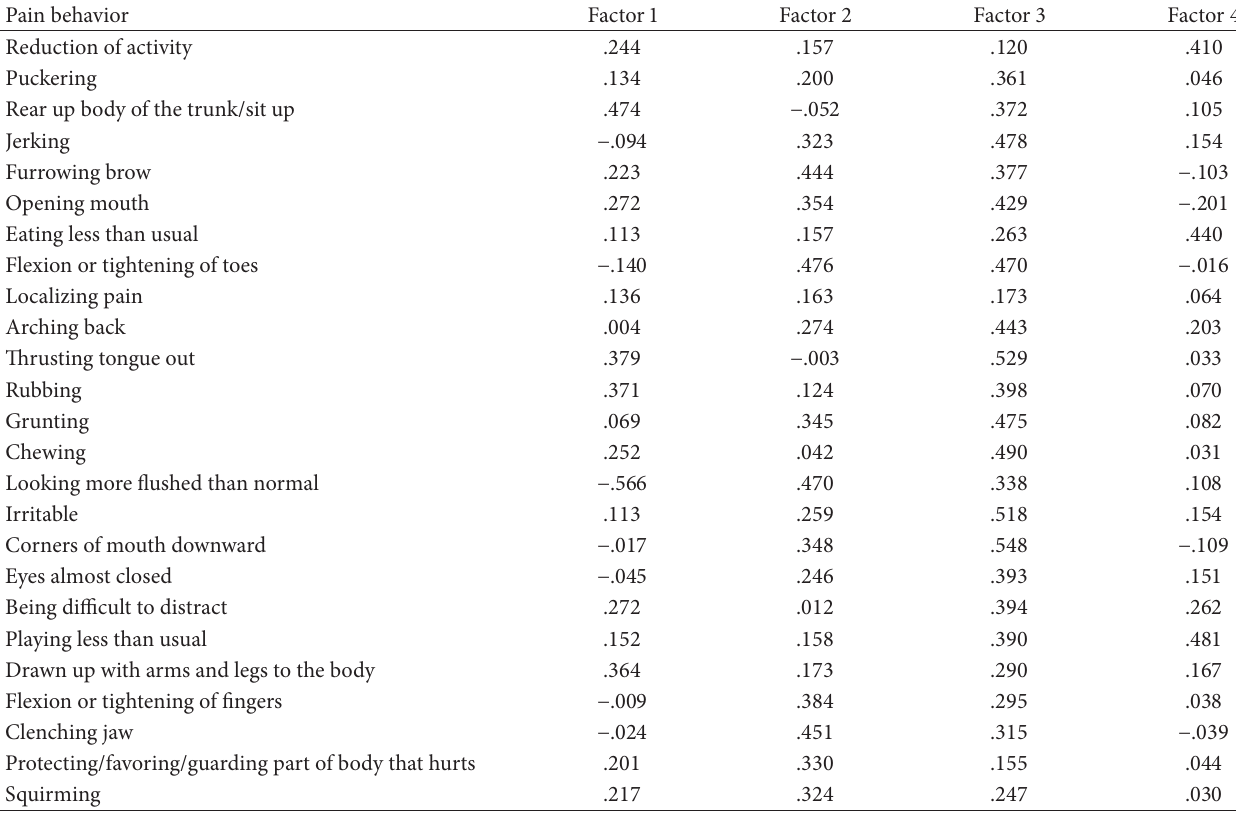
Table 3: Final list of pain behaviors extracted from pediatric observational pain scales that loaded on factor 3 and/or factor 4, loaded on two or more factors, or did not load on any factors. This factor was labeled as the “Ambiguous”